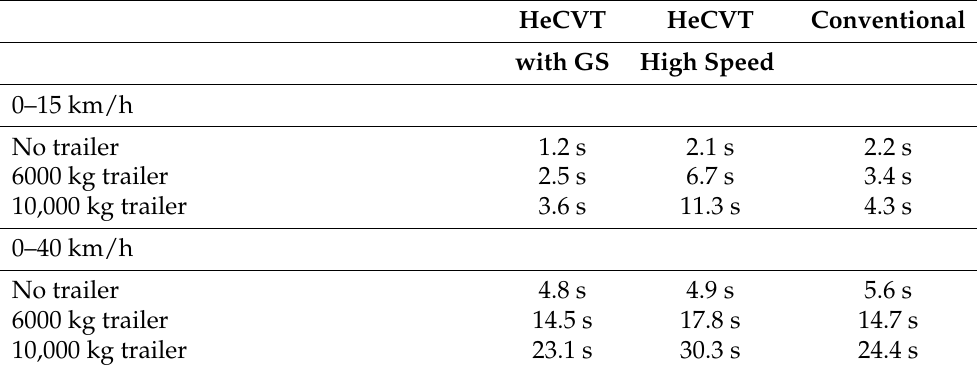
Table 5. HeCVT acceleration performance with different trailer